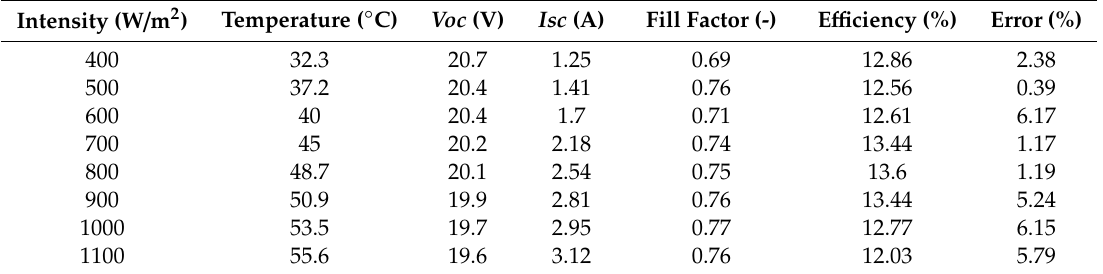
Table 3. Temperature and e ffi ciency of the solar cell with a Cu-Al heat sink with 10 fins. Intensity (W / m 2